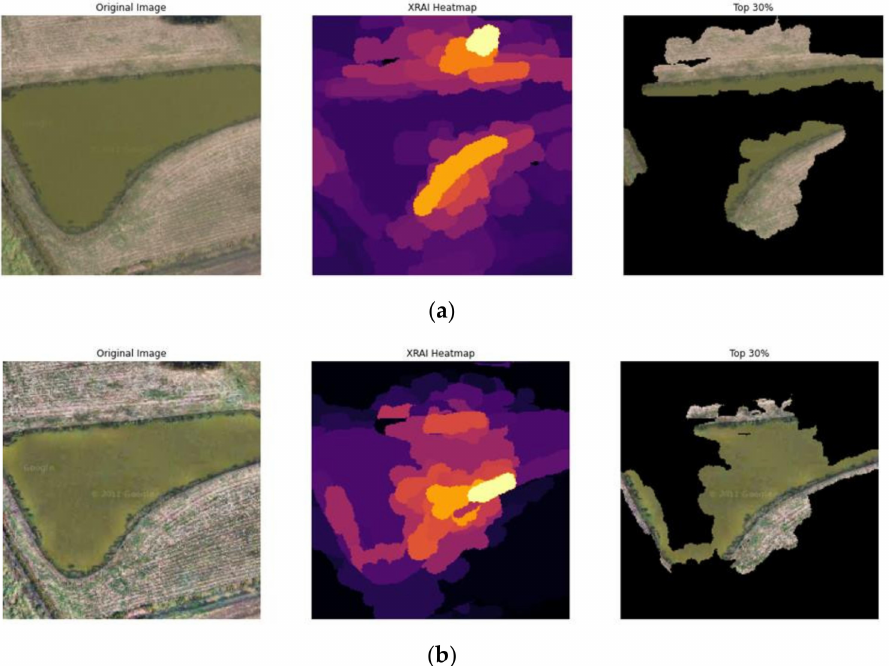
Figure 14. Image (river/lakes category) with XRAI analysis. ( a ) Original image (predicted as field); ( b ) improved image.